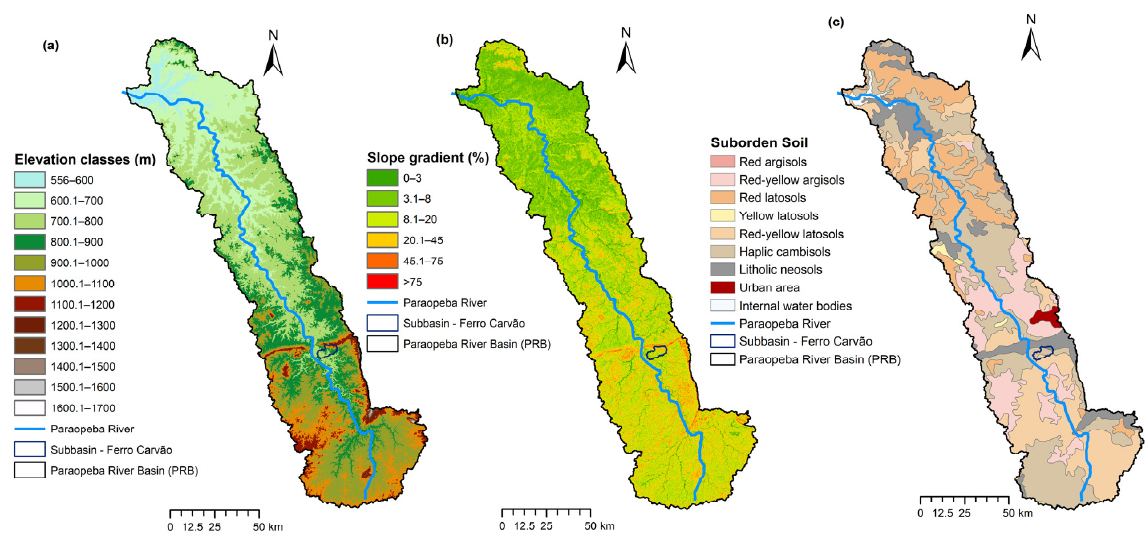
Figure 4. The ( a ) elevation classes; ( b ) slope gradient, and ( c ) suborder soil the Paraopeba River Basin in the State of Minas Gerais, Brazil.